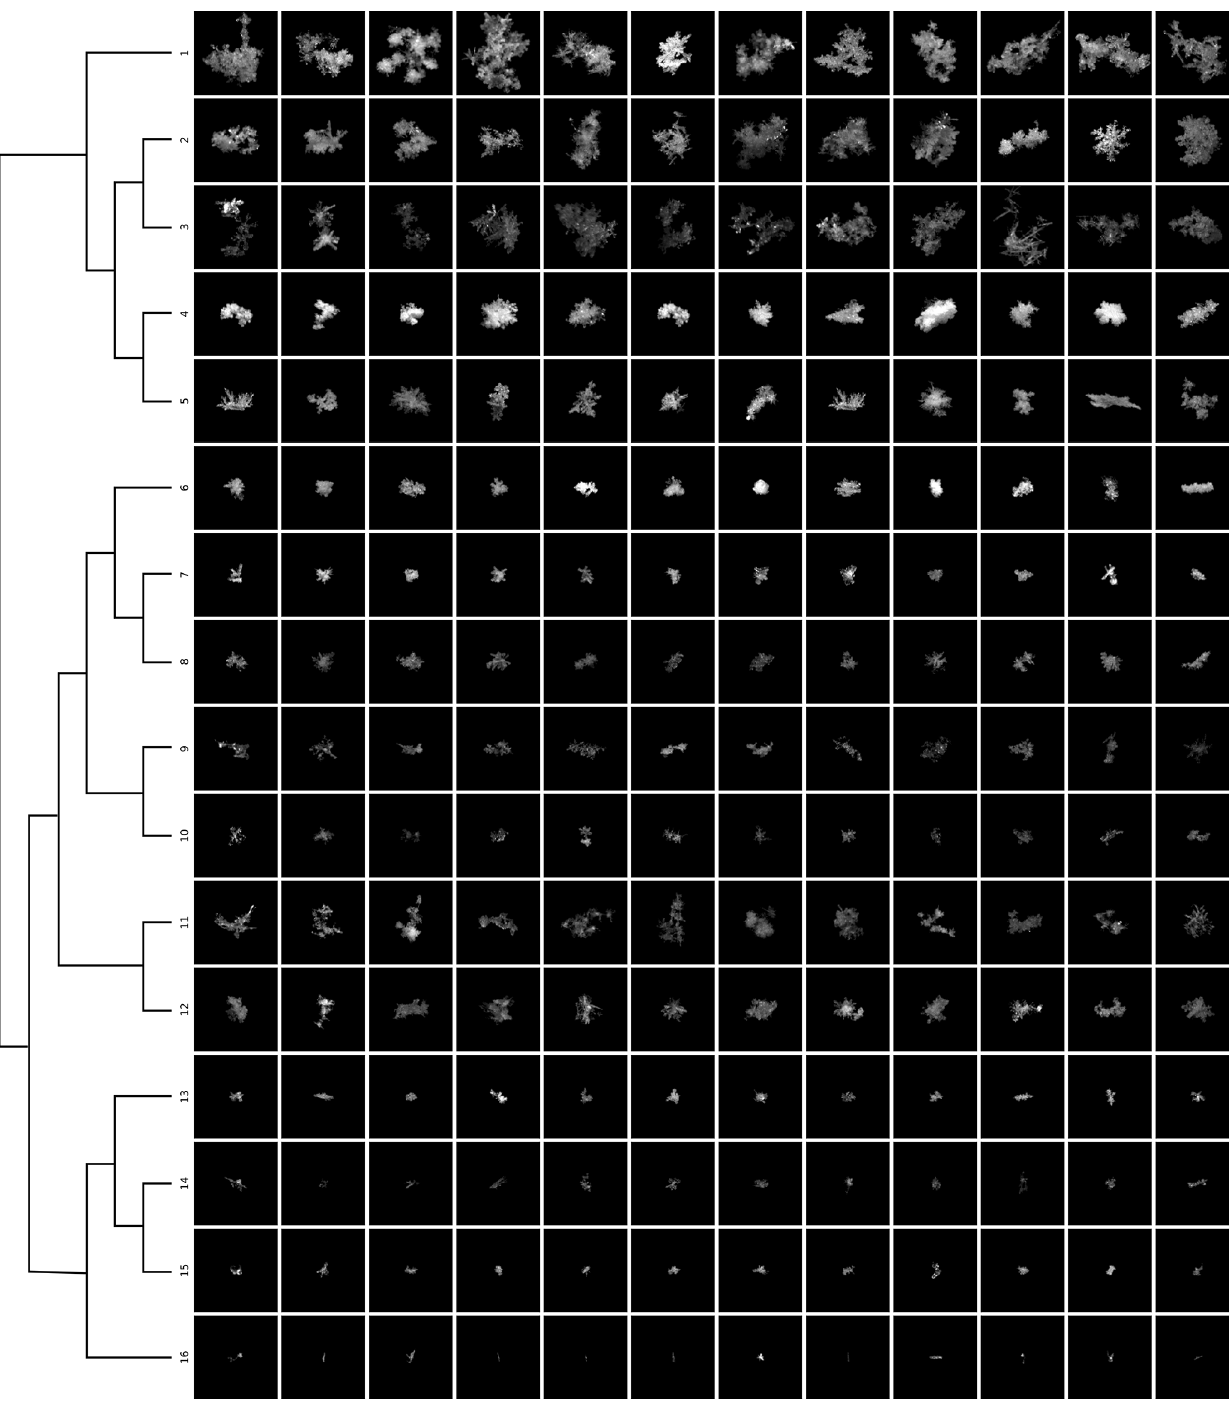
Figure 5. Samples from each class using the 16-class classification. Each row corresponds to a class; the first column shows the particle used as the medoid, while the other columns show random samples. The lines on the left illustrate the tree structure derived with hierarchical